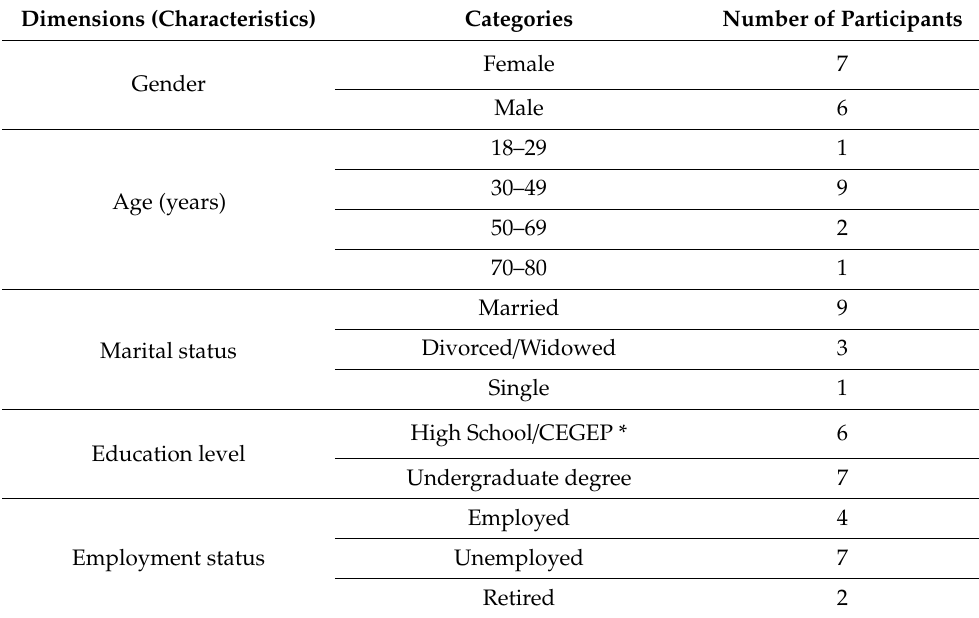
Table 1. Sociodemographic characteristics of